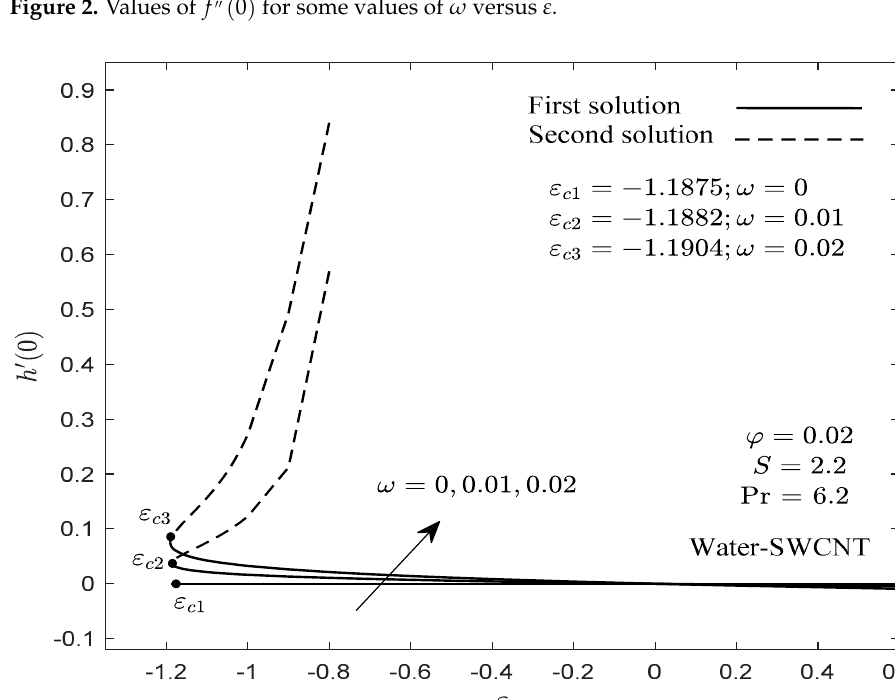
Figure 3. Values of ℎ′(0) for some values of 𝜔 versus 𝜀 .